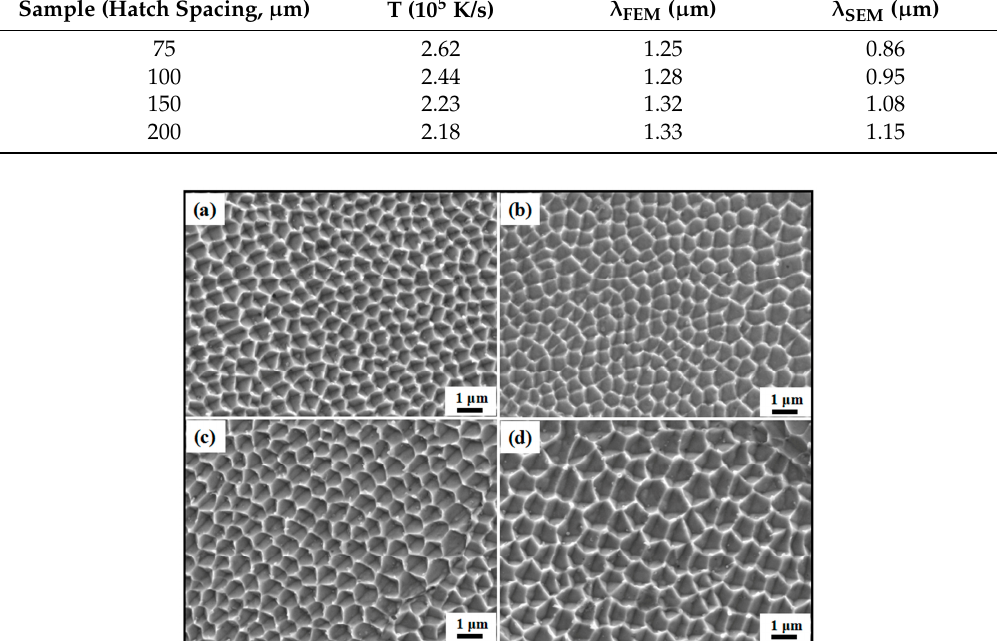
Figure 6. High magnification SEM images of cellular dendrites: ( a ) 75 μ m, ( b ) 100 μ m, ( c ) 150 μ m, and ( d ) 200 µ ( d ) 200 μ m. Table 4. Summary of grain size based on simulation and SEM micrographs.